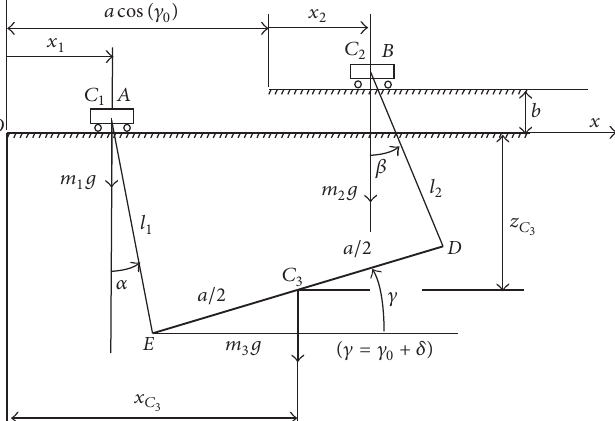
Figure 2: The computational scheme for transportation of heavy cross-beam DE by two bridge cranes 𝐴 and 𝐵